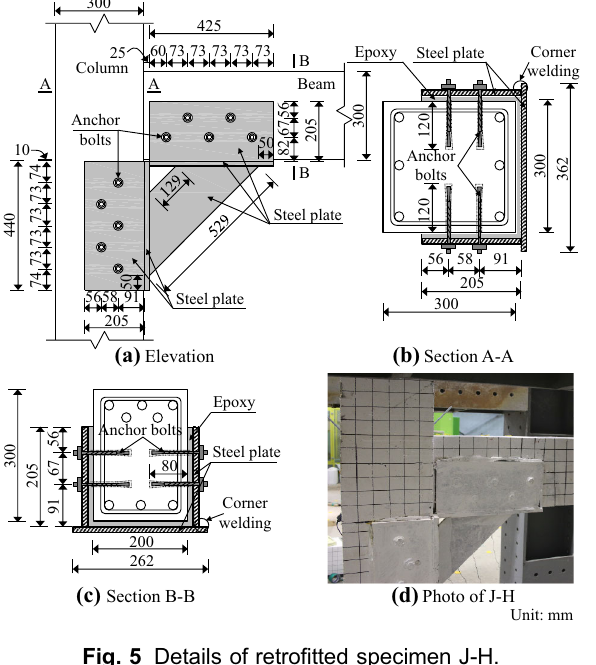
Fig. 5 Details of retrofitted specimen J-H.